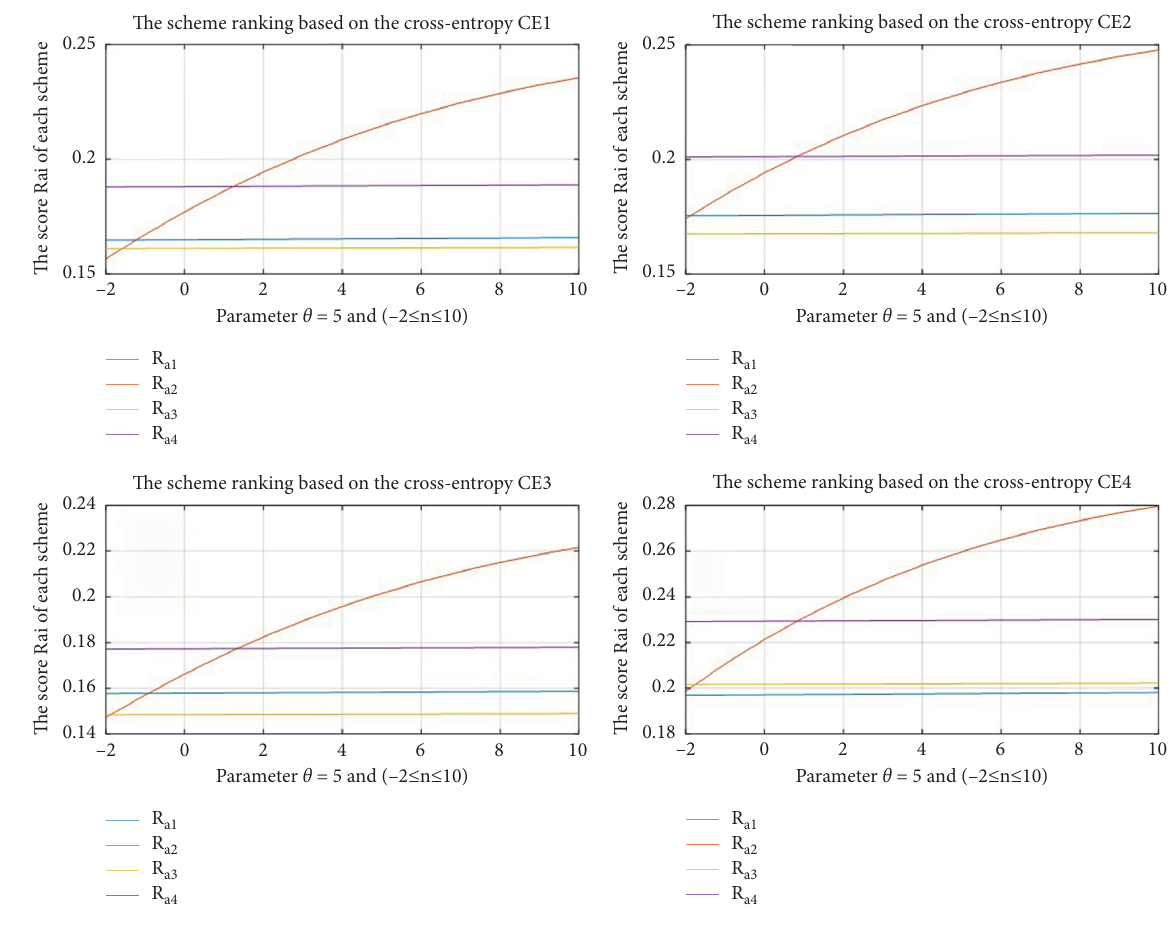
Figure 8: Ranking score of each alternative based on parameters θ � 5, − 2 ≤ n ≤